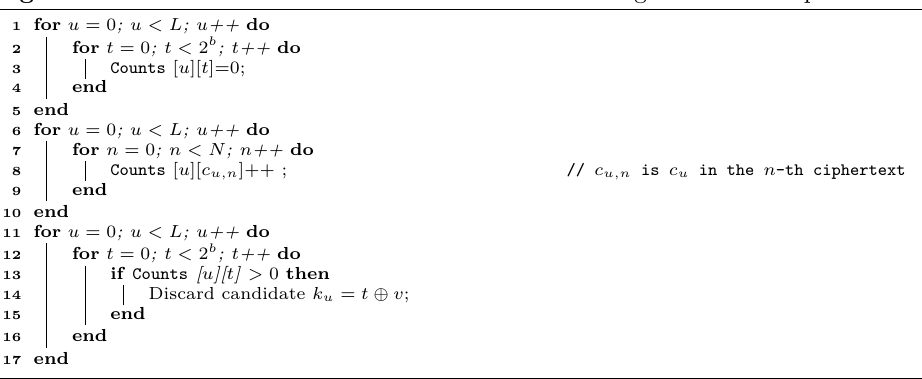
Algorithm 1: Pseudo code of PFA on the last round of a general block